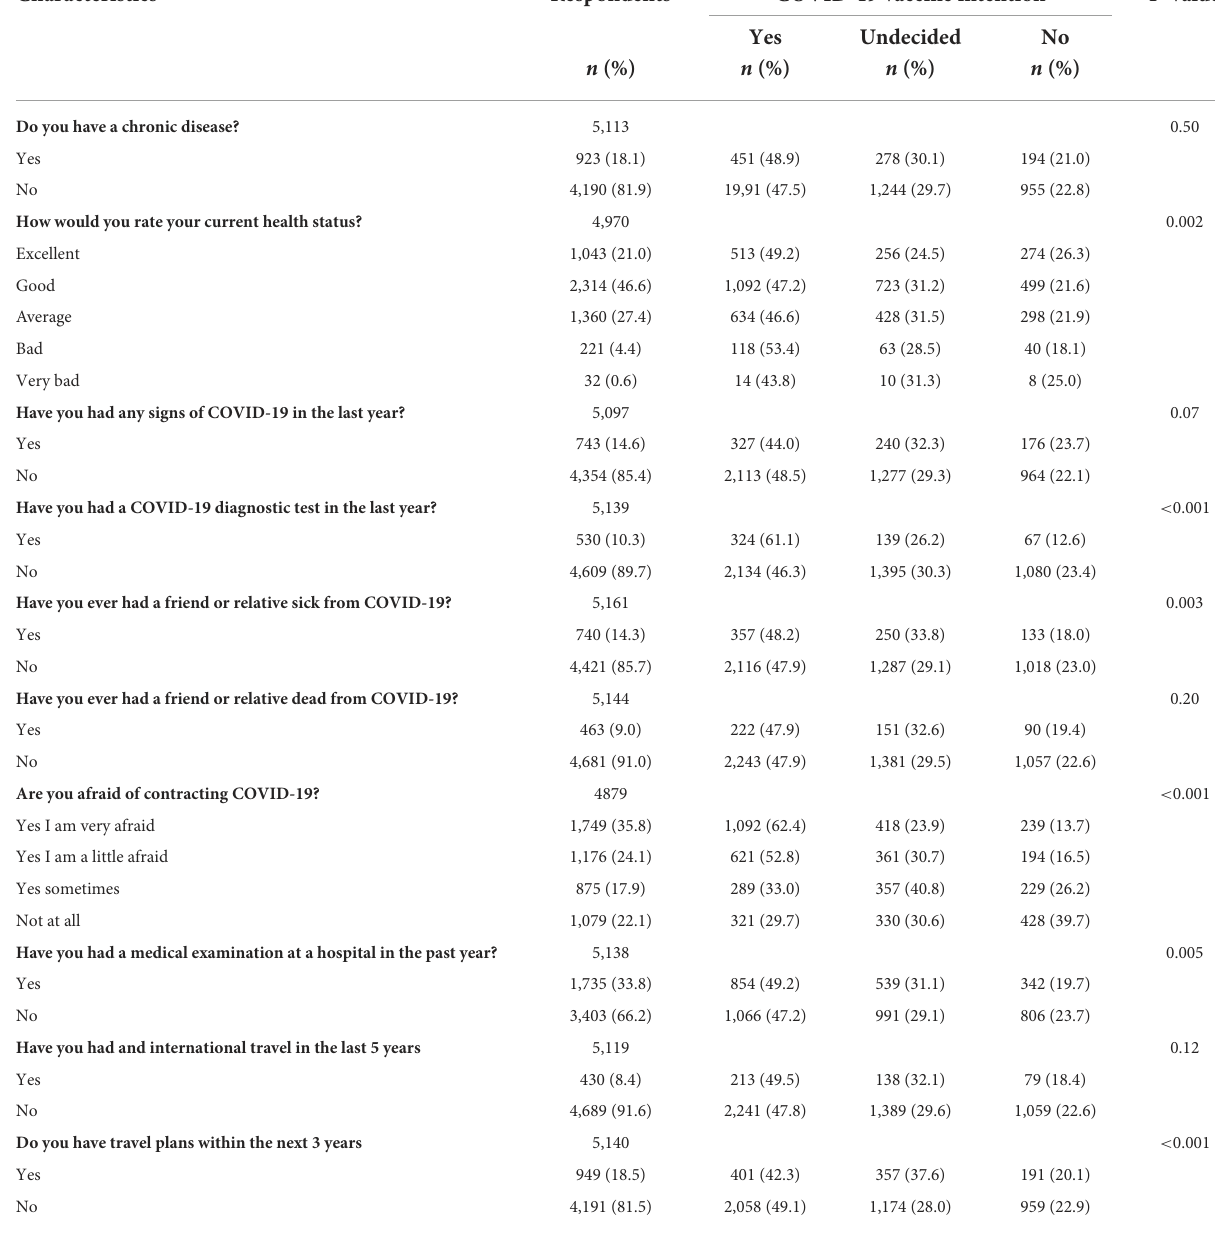
TABLE 2 Respondents’ personal situation and association with COVID-19 vaccine